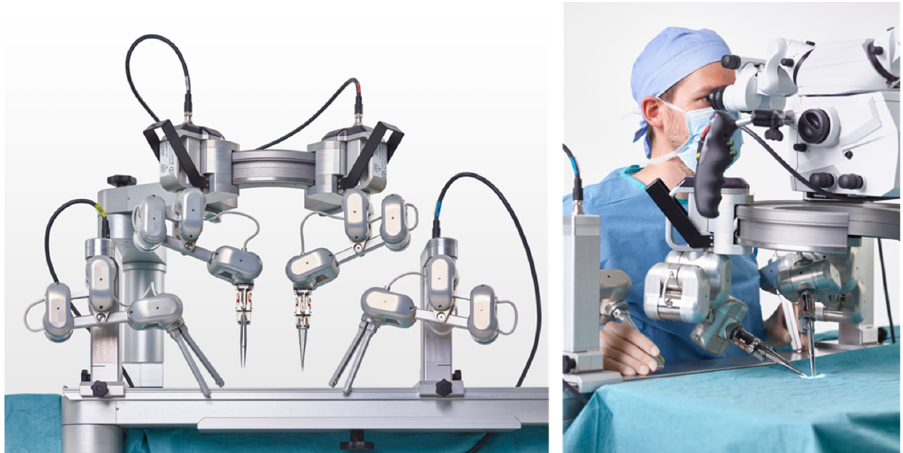
Figure 2. Robotic microsurgery system MUSA from MicroSure (printed with the permission of MicroSure).